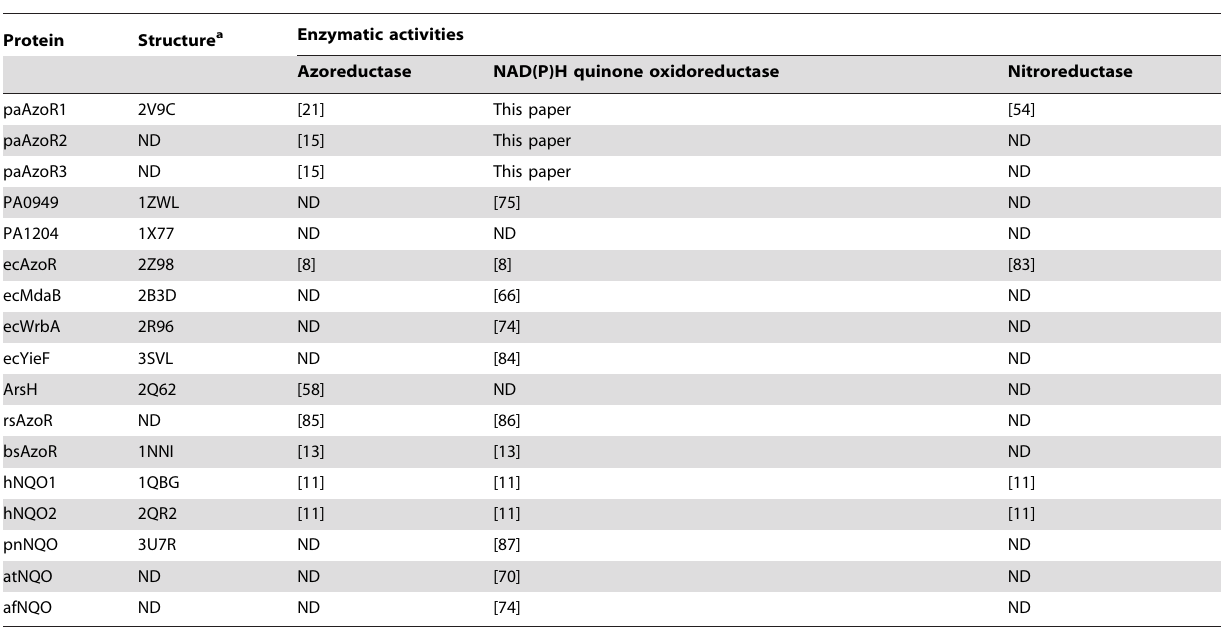
Table 2. Structural and functional information on all azoreductase homologues.